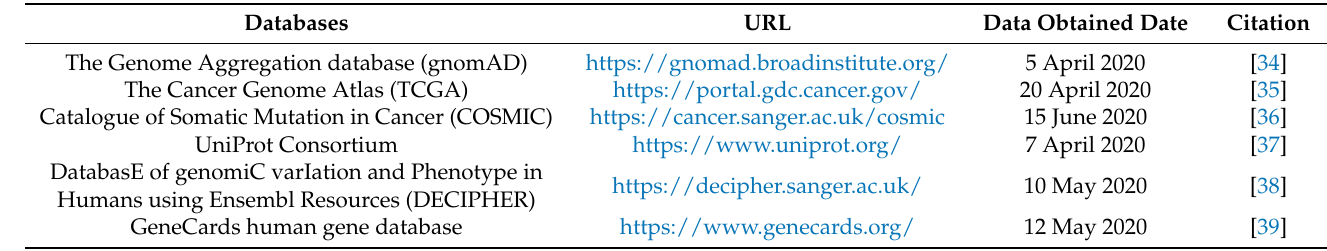
Table 1. Public databases sourced for loss of function data in this